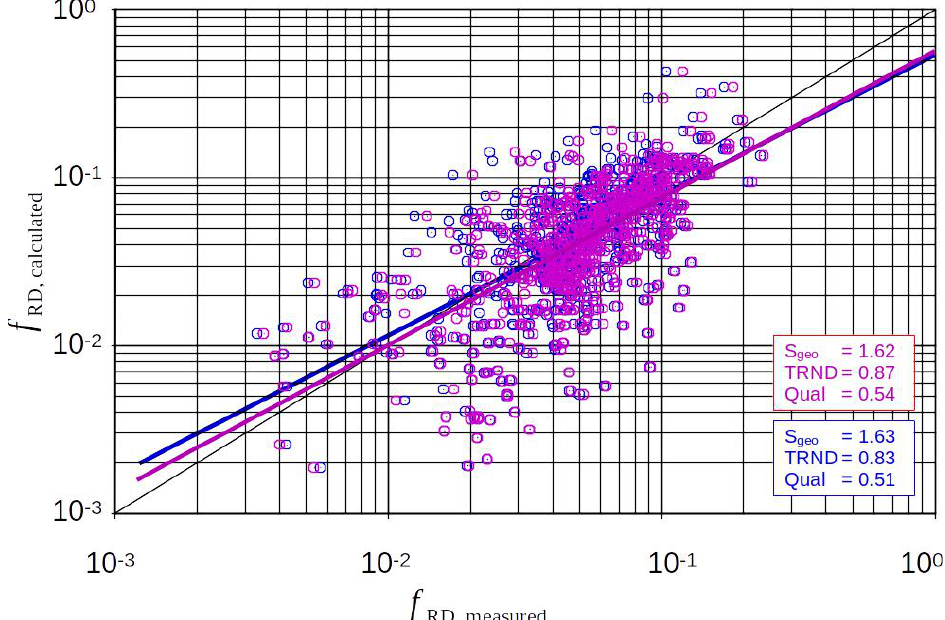
Figure 13. All data: Influence of the effective length assumed to be decisive for skin friction on the “measured” form roughness (=measured total roughness minus calculated skin roughness). Blue: full length L assumed for skin friction; and magenta: only L s effective.